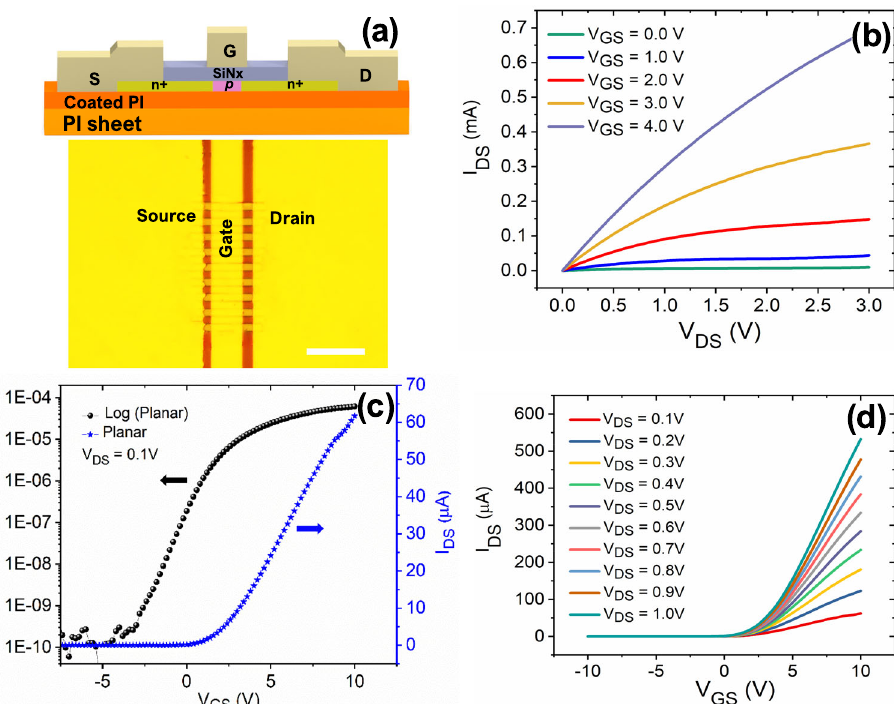
Fig. 3 Electrical characteristics of Si NRFETs. a Schematic cross-sectional view of the Si NRFET device (scale bar, 50 μ m). b Output characteristics of Si-NRFET. c Transfer characteristics ( I DS – V GS ) of Si NRFET with V DS = 0.1 V in logarithmic and linear scales. d Transfer characteristics ( I DS – V GS ) of Si NRFET with V DS varying from 0.1 V to 1 V with the step of 0.1